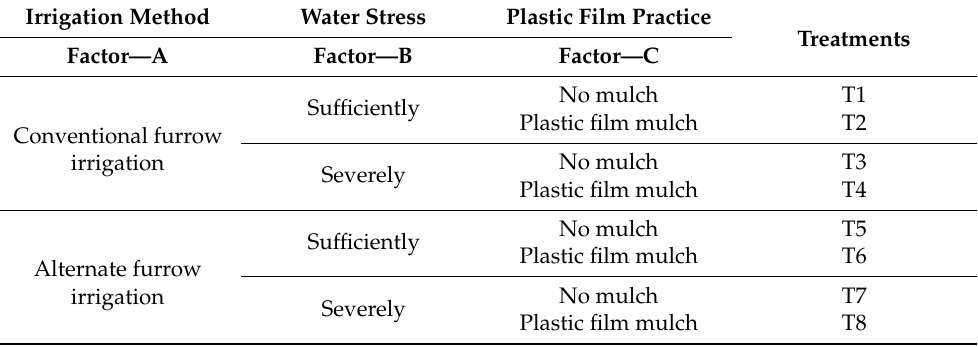
Table 2. Treatment arrangements and combinations (irrigation method, water stress, and plastic film